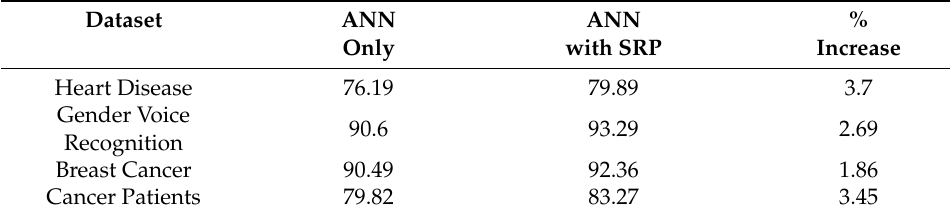
Table 6. A ccuracy of datasets with noisy samples.